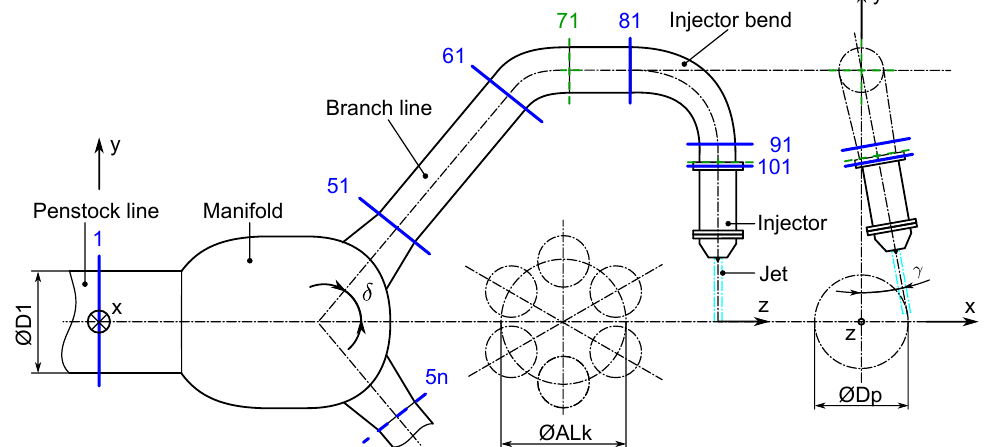
Figure 2. Generic sketch of the AxFeeder (Pelton turbine distributor system with axial inflow) with the individual components and evaluation stations from 1 to 101.